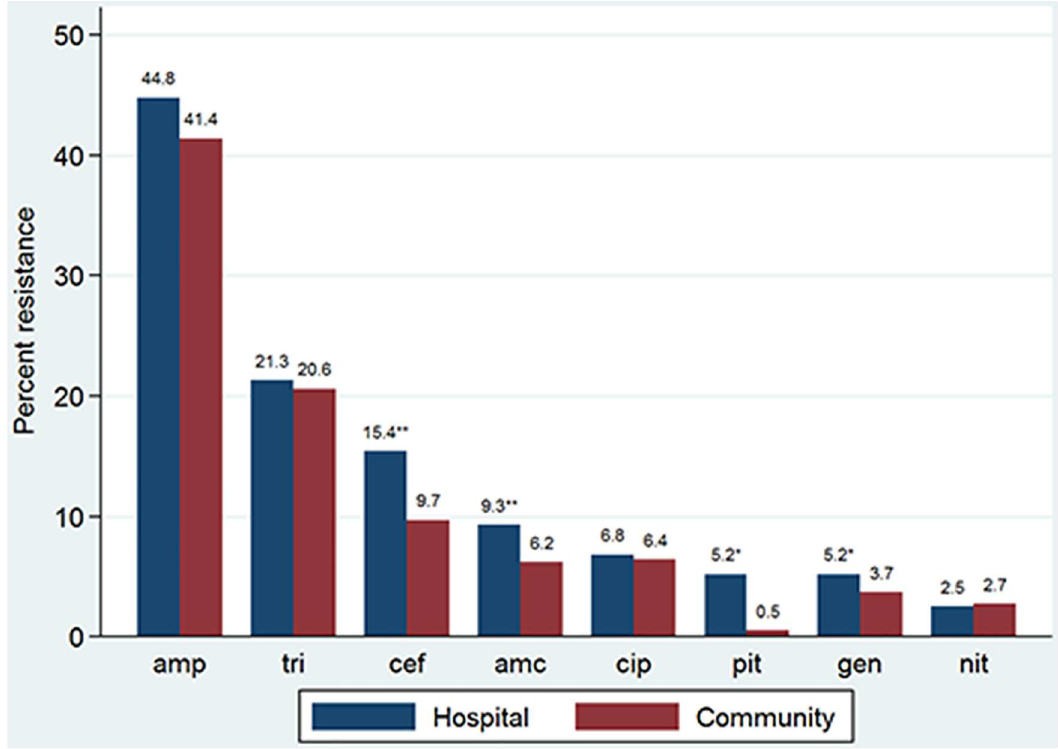
Fig 1. Five-year resistance rates of hospital- and community-acquired E . coli UTIs by selected antibiotics. amp = ampicillin; tri = trimethoprim; cef = cefazolin; amc = amoxycillin-clavulanate; cip = ciprofloxacin; pit = piperacillin- tazobactam; gen = gentamicin; nit = nitrofurantoin. ** 0.001 < p value < 0.05. ** p < 0.001